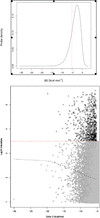
A graphical representation of ΔGcut-off and of ΔG vs. Probe Signal. Top panel shows ΔGcut-off results: the probes having ΔG < −5.2 kcal mol-1 fall to the left of the red line, these were filtered out (21.5 %). Bottom panel shows ΔG vs. Probe signal: the red line denotes background cut-off value; the grey line is the Lowess smoothing line between ΔG and log10 intensities; grey dots represent the probes with very stable structures that have been eliminated in the process; black dots represent the probes with signal higher than the background cut-off value and ΔG < −5.2 kcal mol-1.